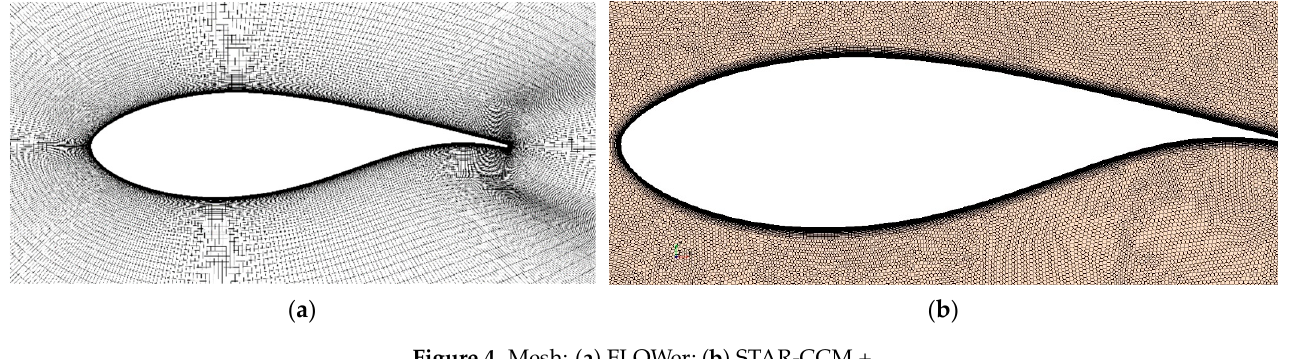
Figure 4. Mesh: ( a ) FLOWer; ( b ) STAR-CCM+.